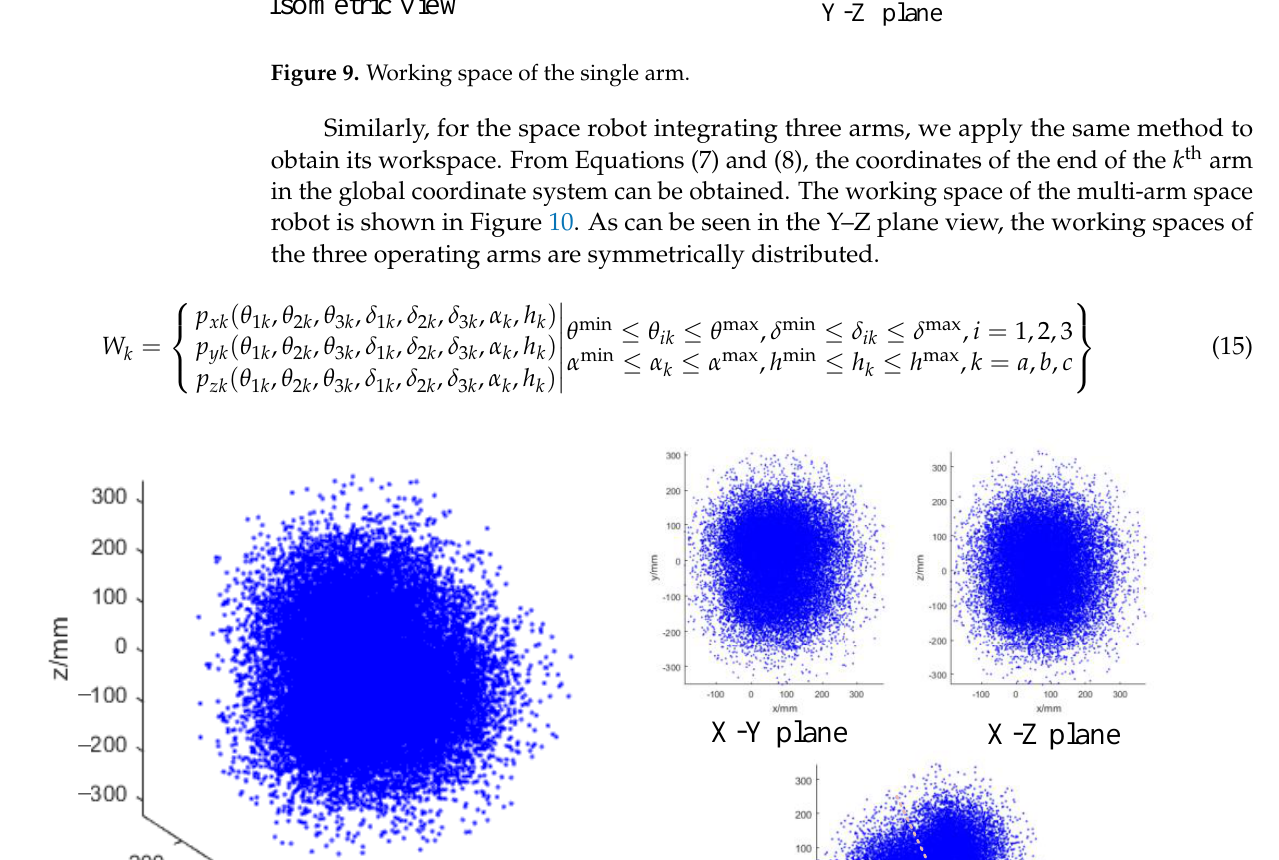
Figure 9. Working space of the single arm.